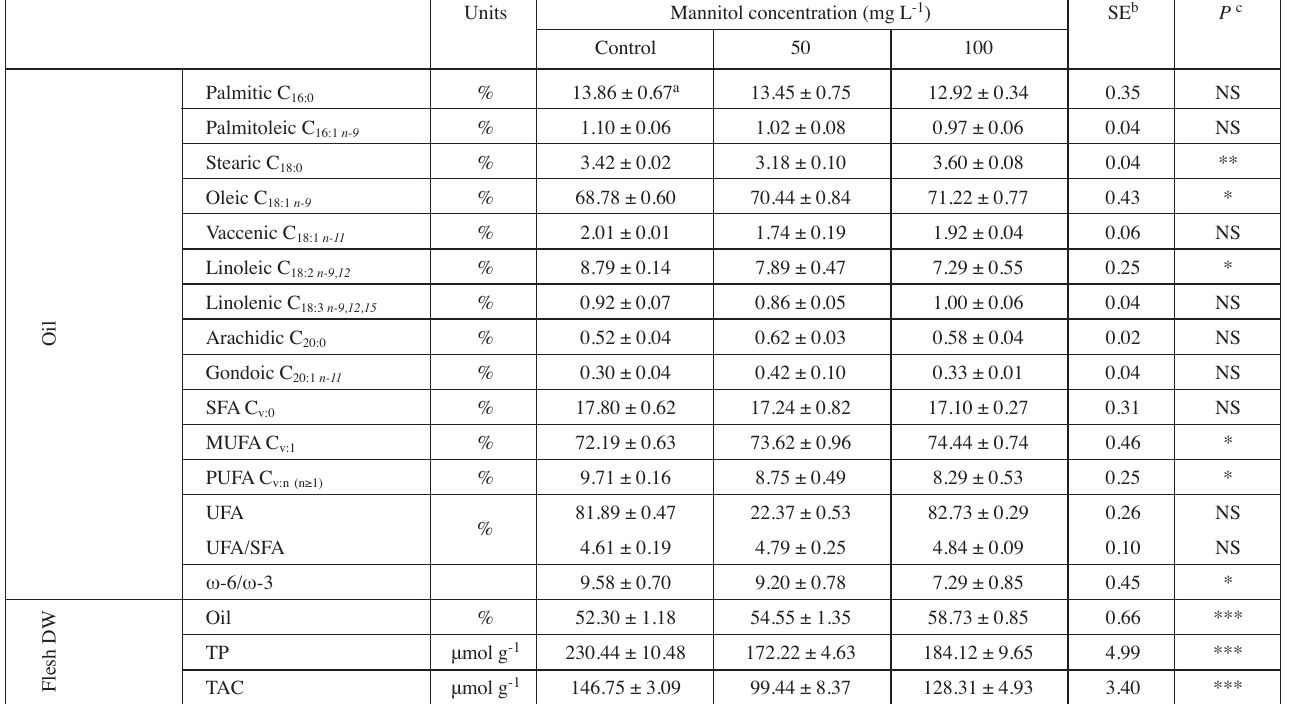
Tab. 2: Effect of preharvest mannitol treatment on content of individual fatty acids (FA), total saturated (SFA), mono-unsaturated (MUFA), poly-unsaturated (PUFA), and total unsaturated FA (UFA), on the unsaturation degree (UFA/SFA) and ω-6/ω-3 ratios in oil, as well as, on oil content, total phenolics concentration (TP) and total antioxidant capacity (TAC) in the flesh in Koroneiki olive fruit, in